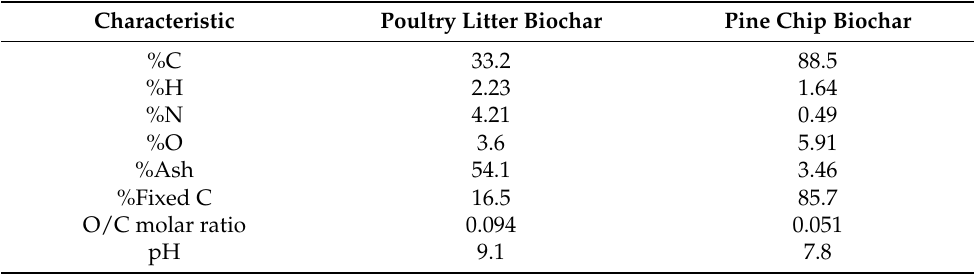
Table 1. Biochar characteristics (results previously published [40]).